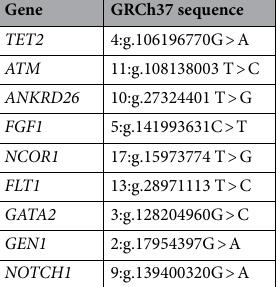
Table 1. Non-pathogenic variants found in both patient and PDX